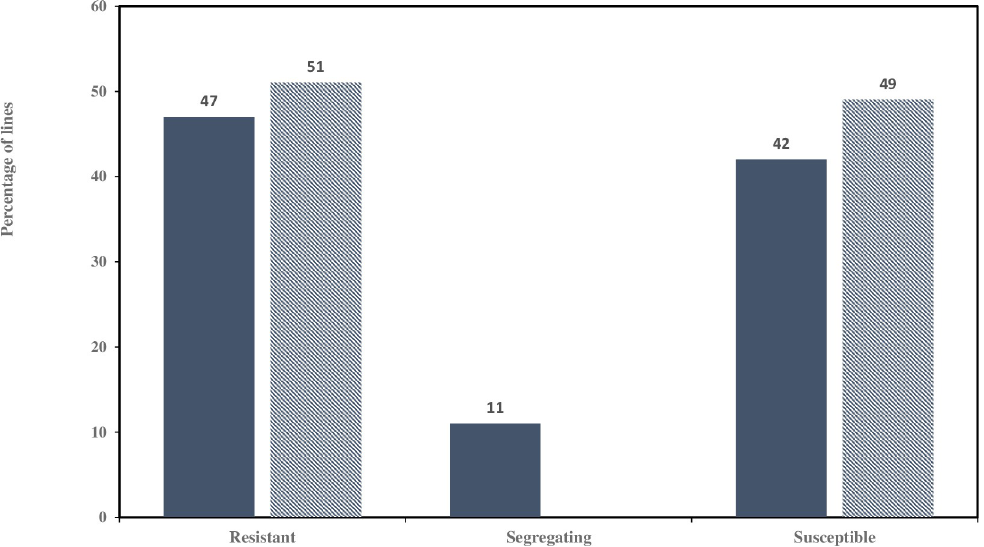
Fig 1. Distribution of crown rust phenotypes of the Pc54 × Pc96 population from greenhouse and field phenotyping at the seedling (solid bars) and flag leaf stages (dashed bars) respectively.